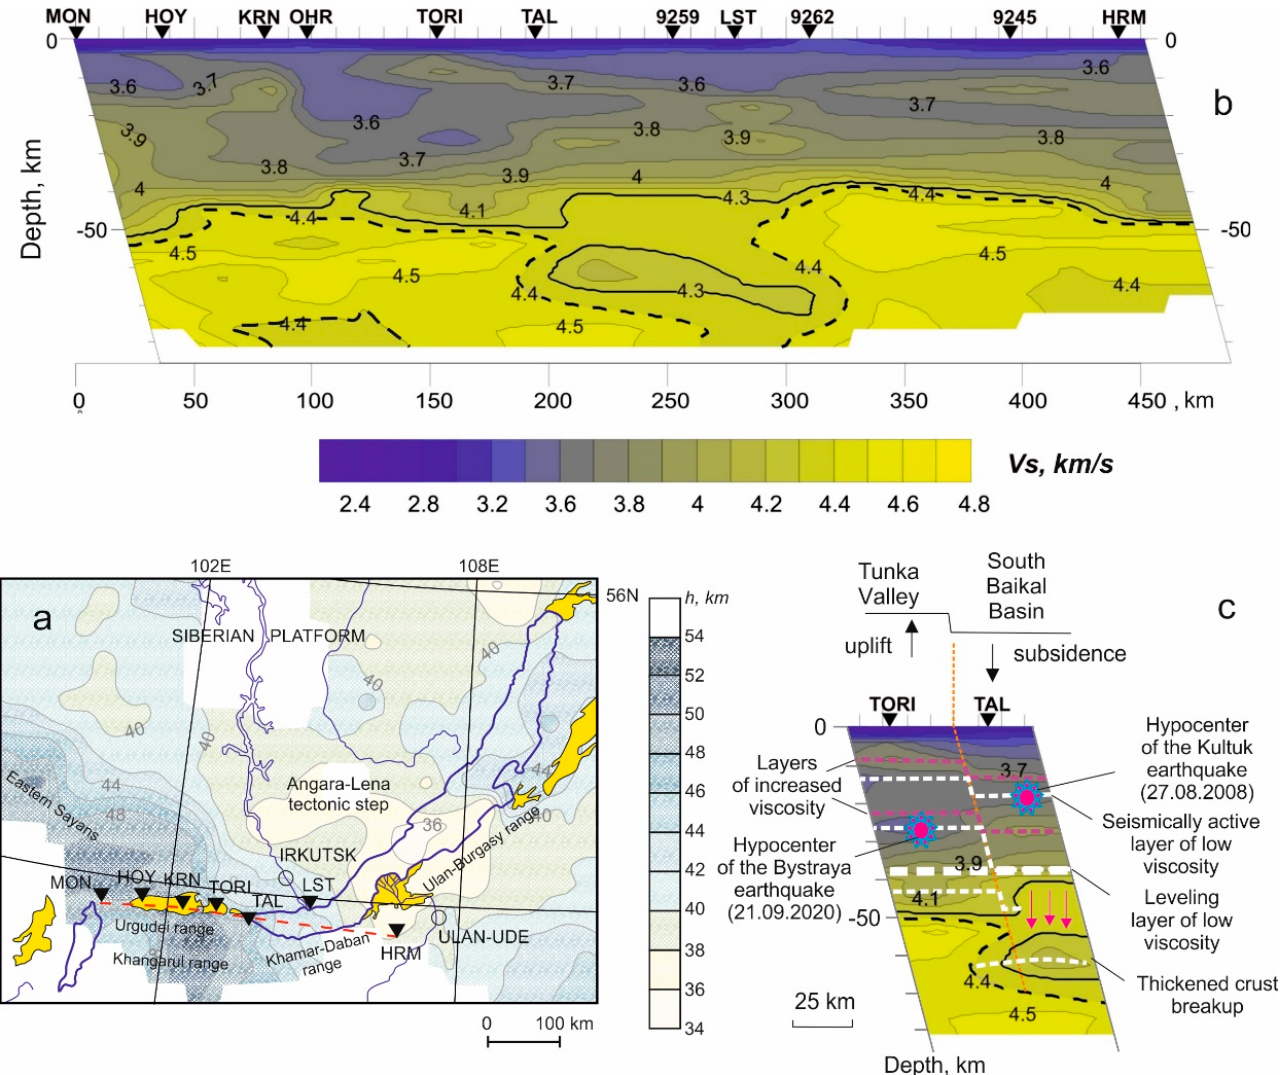
Figure 17. Map of the crustal thickness from data of deep seismic sounding (Vp) in the Baikal Rift Zone and adjacent areas of the Siberian platform and Western Transbaikal ( a ), Vs-section along the Mondy–Khuramsha profile ( b ) and a scheme of the vertical displacement of layers in the South Baikal Basin and Tunka Valley on a fragment of this section ( c ). On panel a, the thickness of the crust of the Angara-Lena step of the Siberian platform as thick as 36–40 km sharply increases along its southwestern edge to 54 km. Seismic tomography profile extends from an area with increased crustal thickness (Mondy) to an area with its reduced thickness under the Selenga saddle (Khuramsha). The Talaya station (TAL) approximately corresponds to the structural junction between the South Baikal Basin and Tunka Valley. The Vs isolines are plotted in steps of 0.1 km/s. Seismic drift is accounted for by the slope of the section. On panel c, white dashed lines indicate vertical displacements of the low-velocity layers, burgundy dashed lines show those of the high-velocity layers (explanation in the text). The depths of the hypocenters of the 2008 Kultuk and 2020 Bystraya earthquakes (16 and 26 km) are shown after Melnikova et al. [114] and Seminsky et al. [56]. The map on panel a is modified after Mats et al. [115]. The section on panel b is adopted from Mordvinova et al. [116].